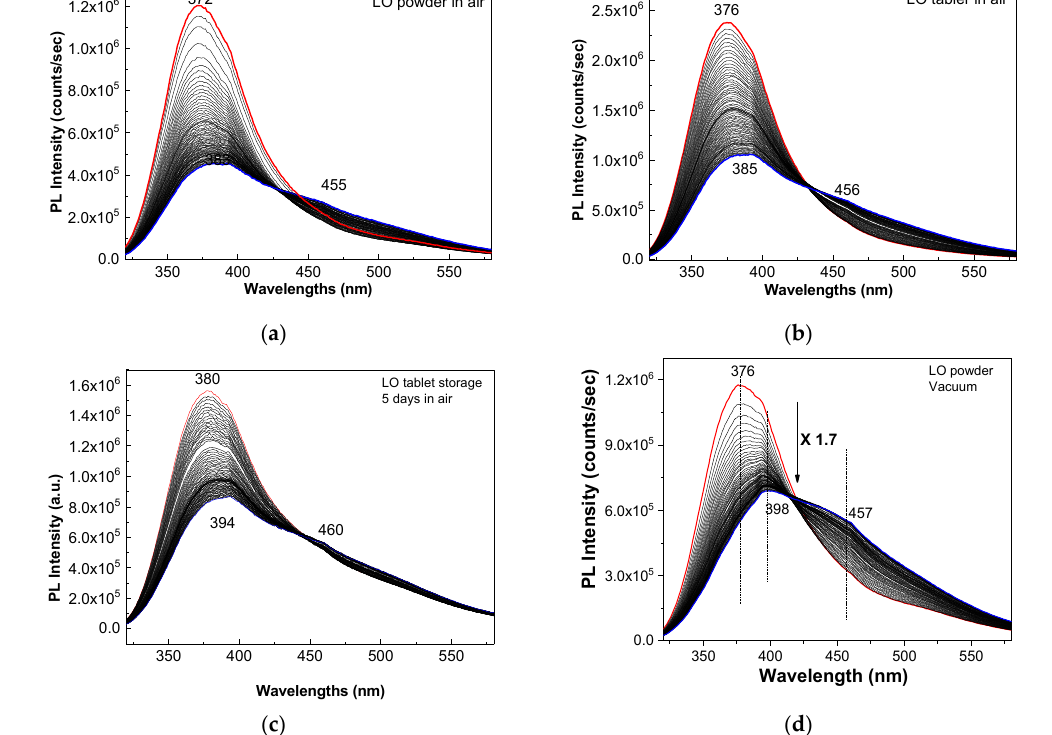
Figure 1. PL spectra of the LO drug in powder state ( a ) and tablet ( b ) and their evolution when the samples are exposed time of 187 min to UV light. The behavior of PL spectra of the LO tablet storage in air, time of 5 days, and their evolution under the UV light exposure ( c ). The influence of the vacuum conditions on the photodegradation of LO in powder state ( d ). In all figures, the red and blue curves correspond to PL spectra in the initial state and after 187 min. of exposure to UV light when the excitation wavelength was of 300 nm. The black curves correspond to the intermediate PL spectra.